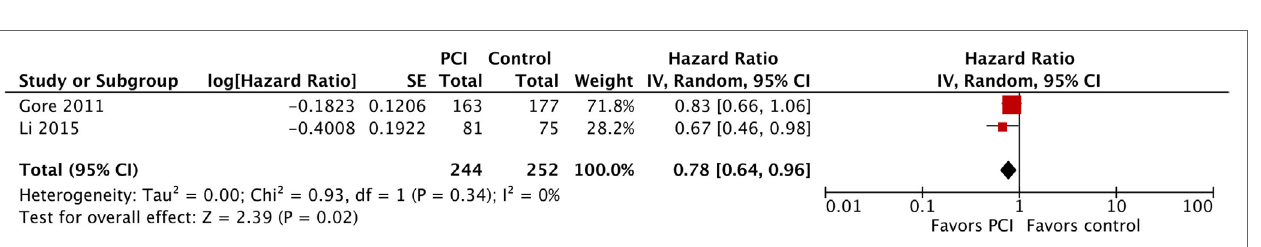
FigURe 9 | Effect of PCI on disease-free survival in 496 patients with stage III non-small-cell from two recent trials. Abbreviations: PCI, prophylactic cranial irradiation; CI, confidence interval.